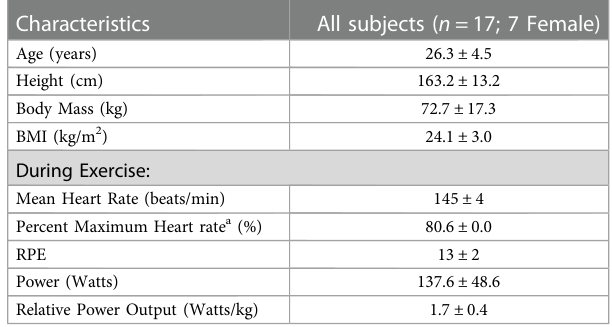
TABLE 1 Participant characteristics and exercise performance measures. Values are presented as means±SD.